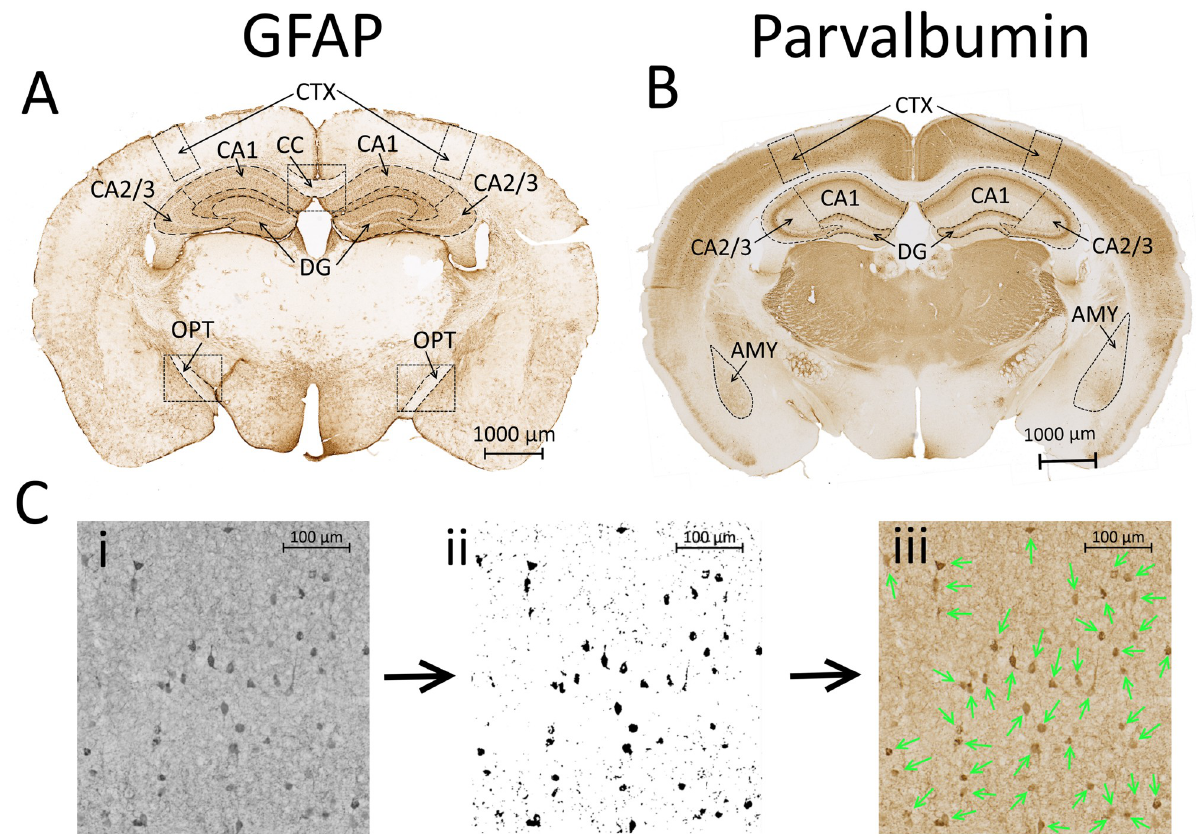
Fig 2. Glial fibrillary acidic protein (GFAP; A ) staining density was analyzed in the corpus callosum (CC) and bilaterally in the perilesional cortex (CTX), hippocampus (HP; subdivided into CA1, CA2/3 and dentate gyrus (DG) regions) and optic tracts (OPT). Parvalbumin cell density ( B ) was quantified bilaterally in the amygdala (AMY), perilesional CTX and DG, CA1 and CA2/3 subregions of the HP. Fig. 2C illustrates, in a sample of CTX, the process employed for counting parvalbumin cells. Panel ii shows the thresholded image from the black and white sample ( i ); the counted cells using the particle analysis feature of ImageJ are marked with arrows on the original image in ( iii